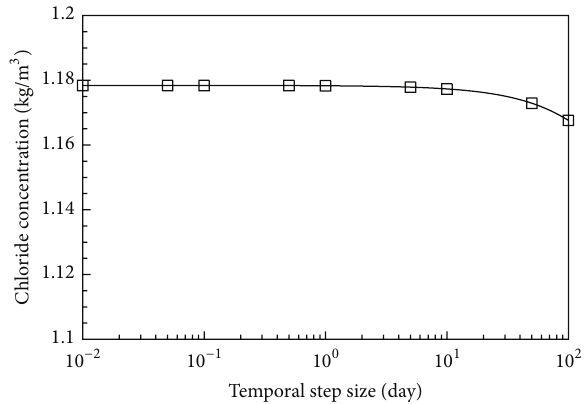
Figure 3: Exposure years taken to reach the CTL (1.2kg/m 3 ) as a function of column radius. The CTL values were monitored at the minimum concrete depth (80 mm) [34]. Numerical experiments were performed with respect to three water to cement ratios and two surface concentration models. 𝑅 = 0 . 4